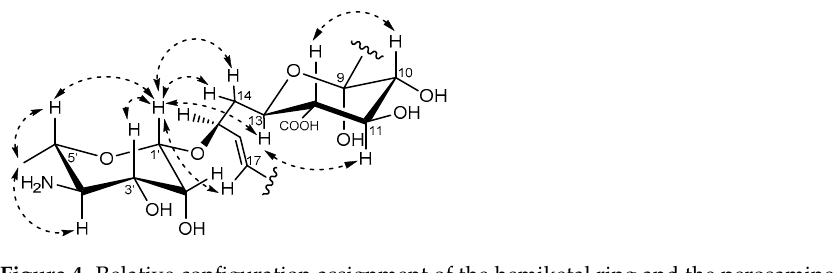
Figure 4. Relative configuration assignment of the hemiketal ring and the perosamine in actinospene ( 1 ) based on NOESY correlations. ( 1 ) based on NOESY